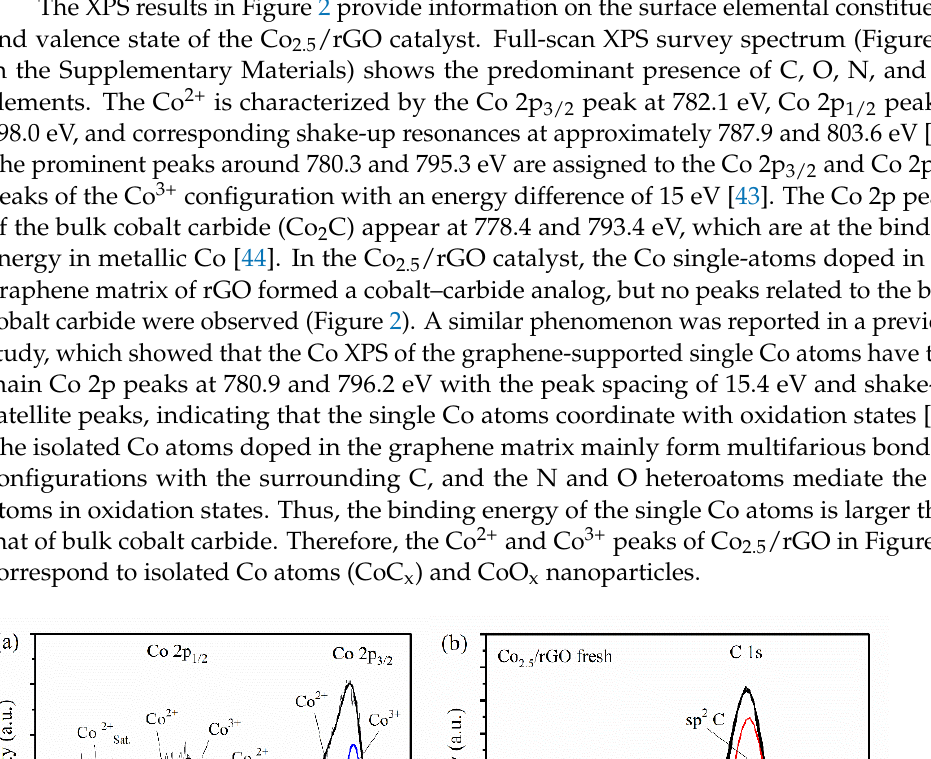
Figure 1. Characteristic results of Co 2.5 /rGO including ( a ) TEM image, ( b ) HRTEM image, ( c ) particle size distribution, and ( d , e ) HAADF-STEM images.